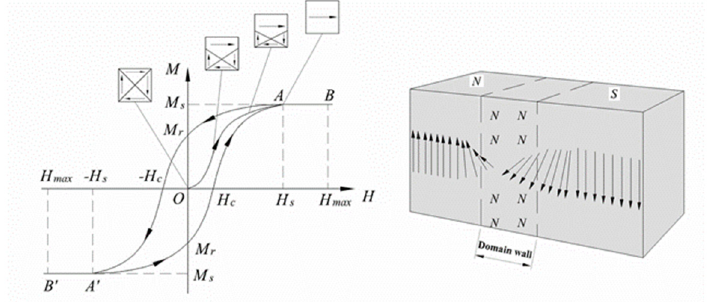
Figure 3. Schematic representation of initial magnetization curve, hysteresis loop, and domain wall structure for a typical ferromagnetic material, where M S is the saturation magnetization, M r is the remanent magnetization at H = 0, and H C is the coercivity.